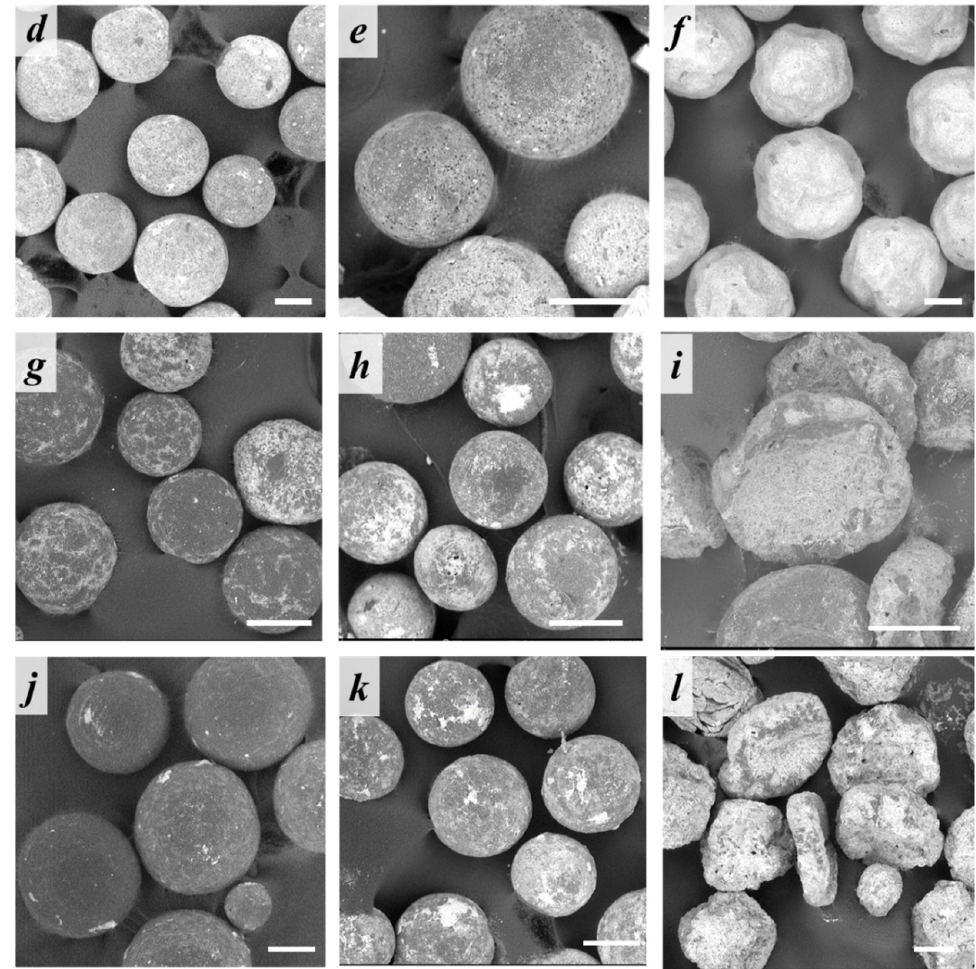
Figure 9. SEM micrographs of the ( a – f ) PLA- or ( g – l ) PCL-based microparticles containing poly- mer/nHA ratio in oil phase of ( a , d , g , j ) 3/1, ( b , e , h , k ) 1/1, or ( c , f , i , l ) 1/3 ( a – c , g – i ) without or ( d – f , j – l ) with preliminary US treatment of the oil phase. Scale bars: 100 µm.